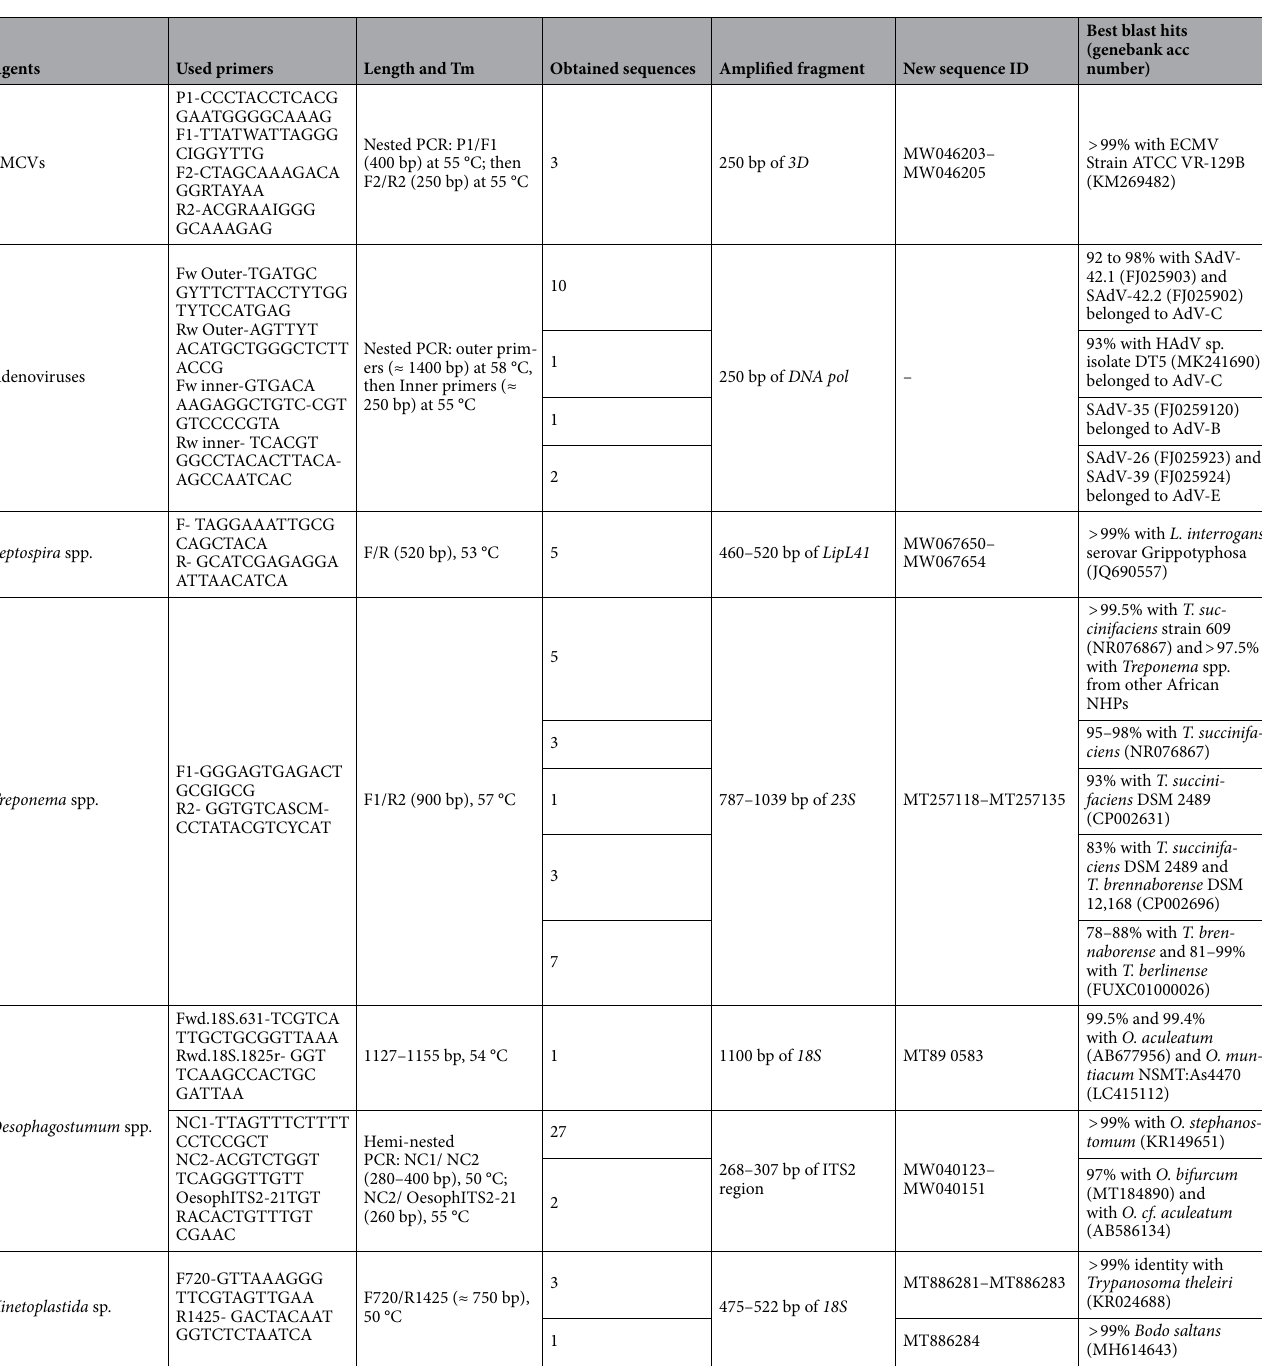
Table 2. Generated sequences in this study and their